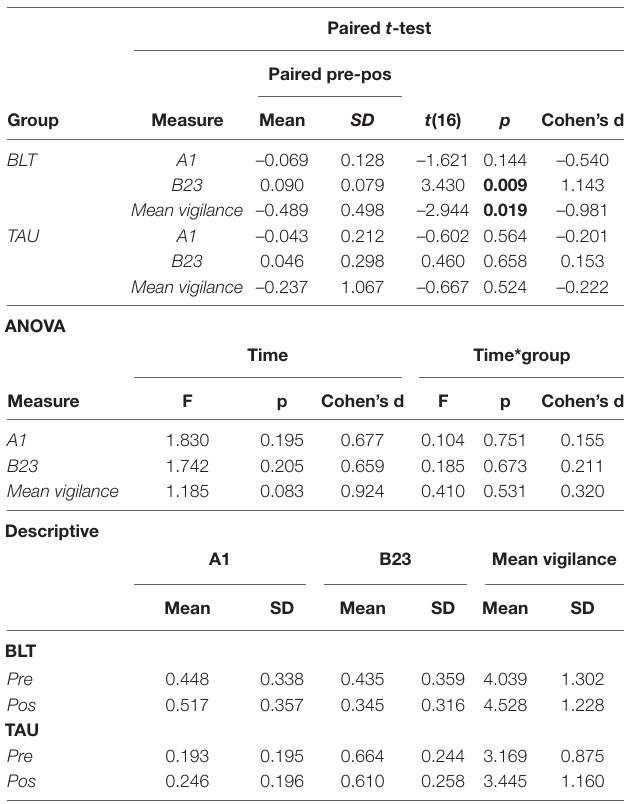
TABLE 2 | Effect of time on EEG vigilance